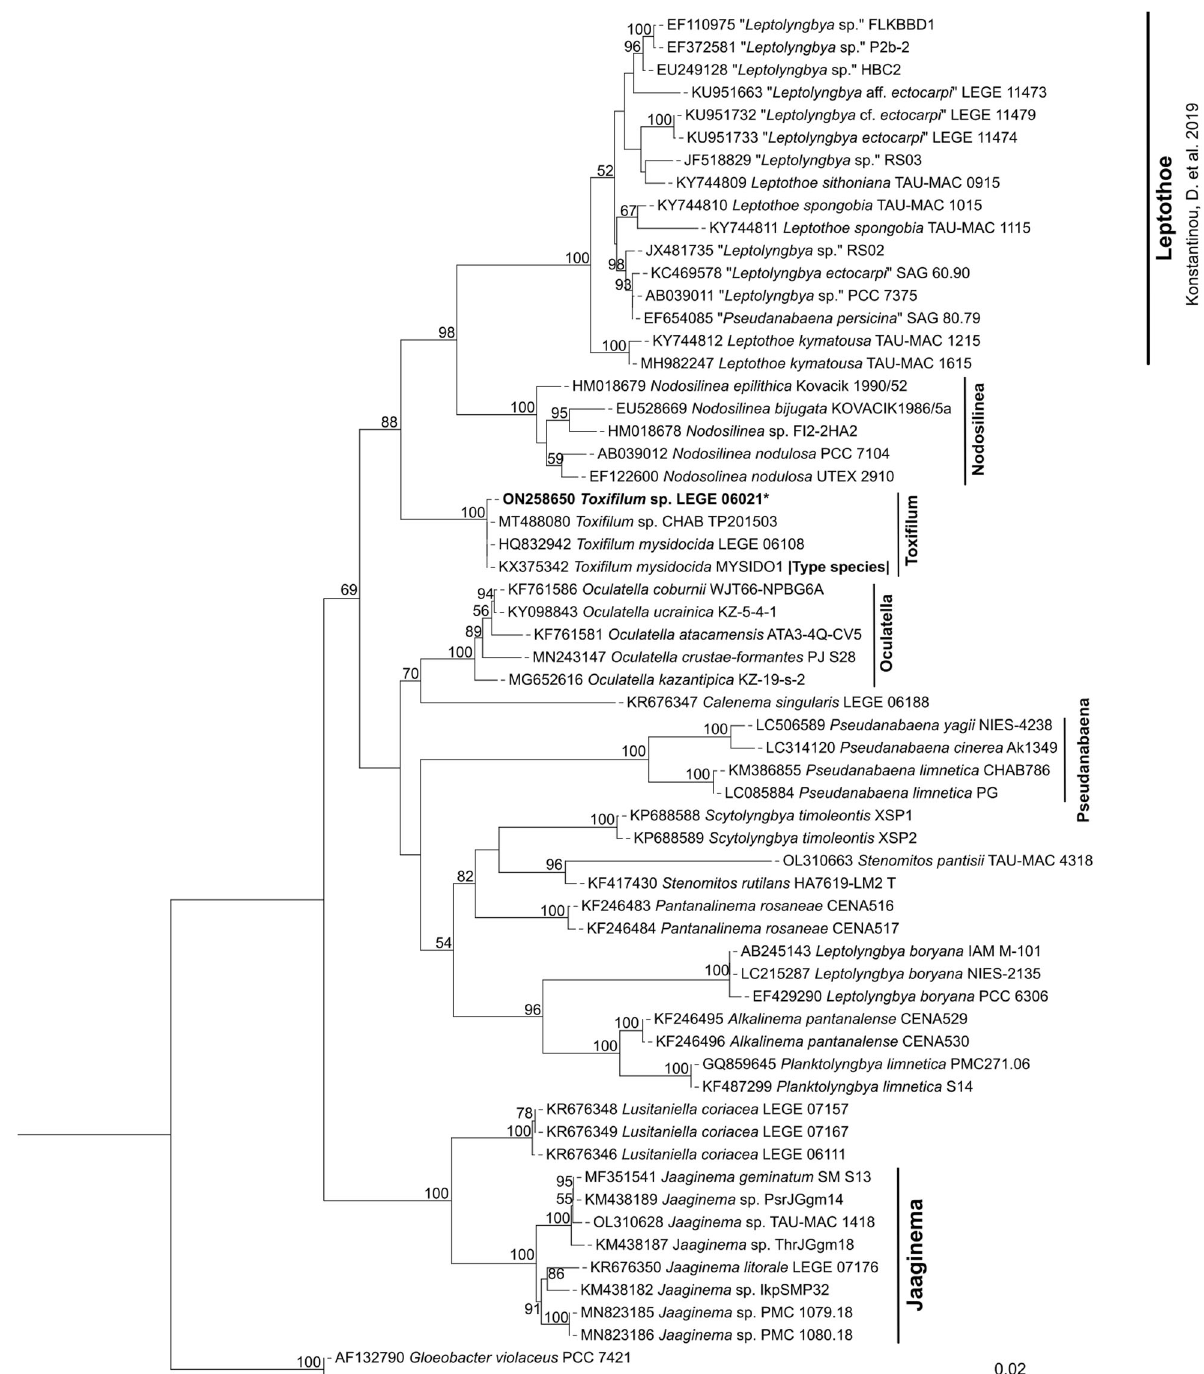
Fig. 1 Maximum likelihood (ML) phylogenetic tree based on 61 partial 16S rRNA gene sequences of cyanobacteria strains belonging to the orders Pseudanabaenales and Synechococcales. Gloeobacter violaceus PCC 7421 and Gloeobacter violaceus PCC 8105 were used as outgroup. Phylogenetic position of Toxi fi lum sp. LEGE 06021 is indicated in bold. Bootstrap values over 50% are indicated at the nodes. Black stars represent the strains whose sequences were obtained in this work. Strains labeled with quotes indicate that names correspond to Genbank